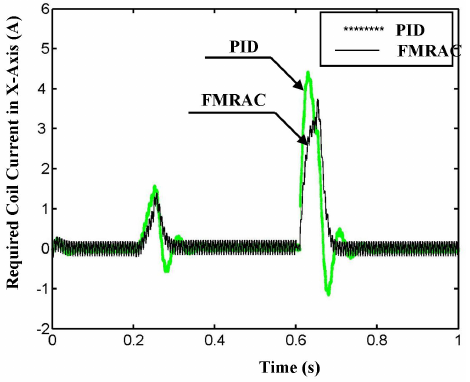
Figure 11. Comparison of required coil current for the ECAMA in the X -axis under various control laws.